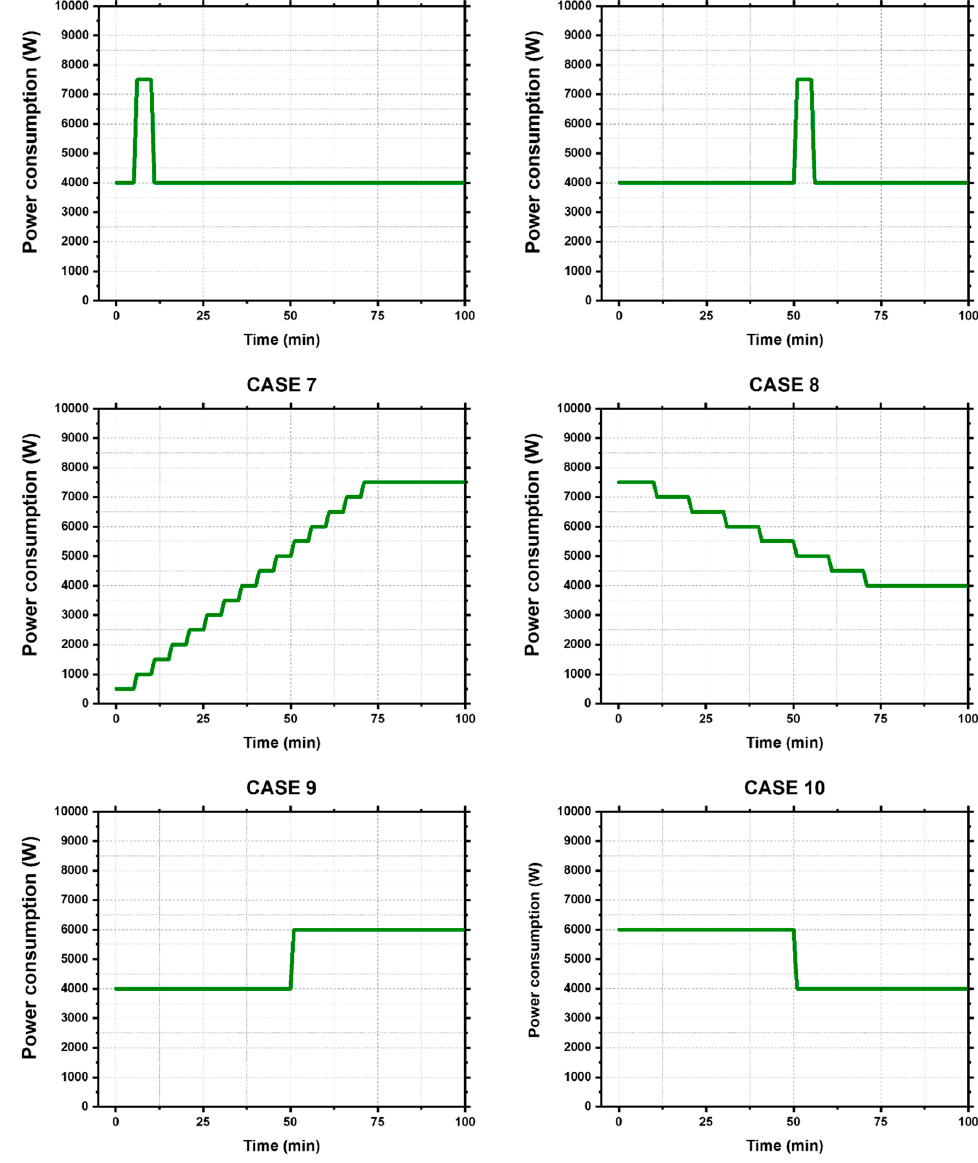
Figure 5. Power consumption scenarios.